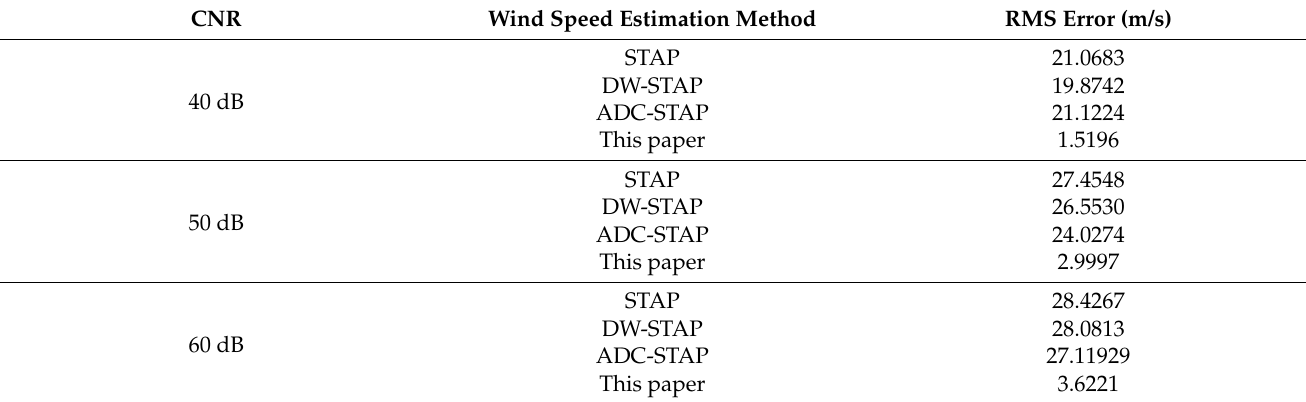
Table 2. Comparison of RMS error of wind speed estimation results under different CNR conditions.